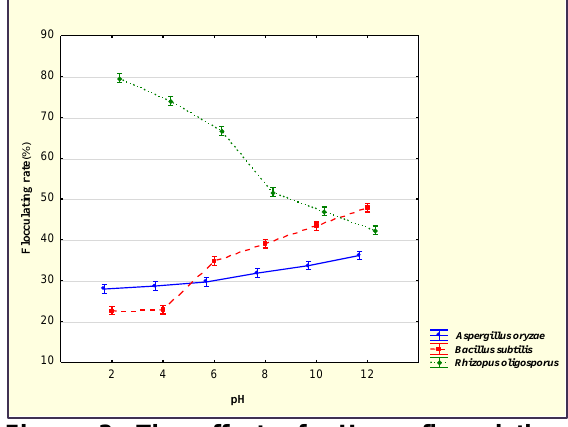
Figure 3. The effect of pH on flocculating activity in 5 g/l kaolin suspension